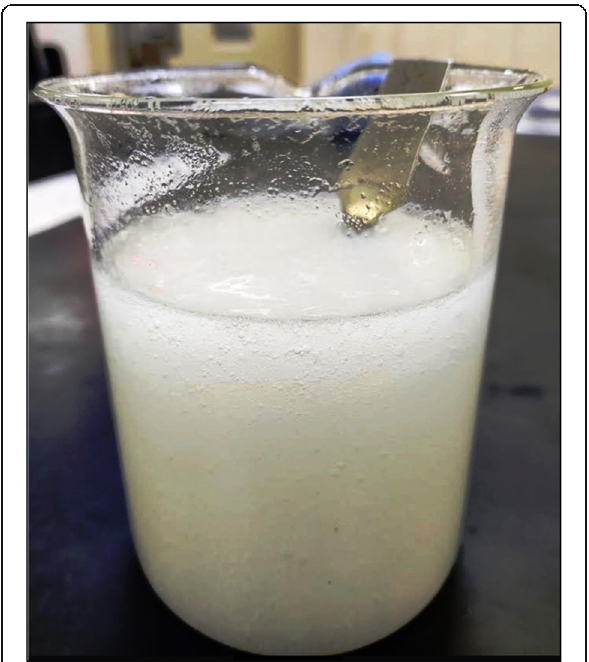
Fig. 4 Instant linear gel